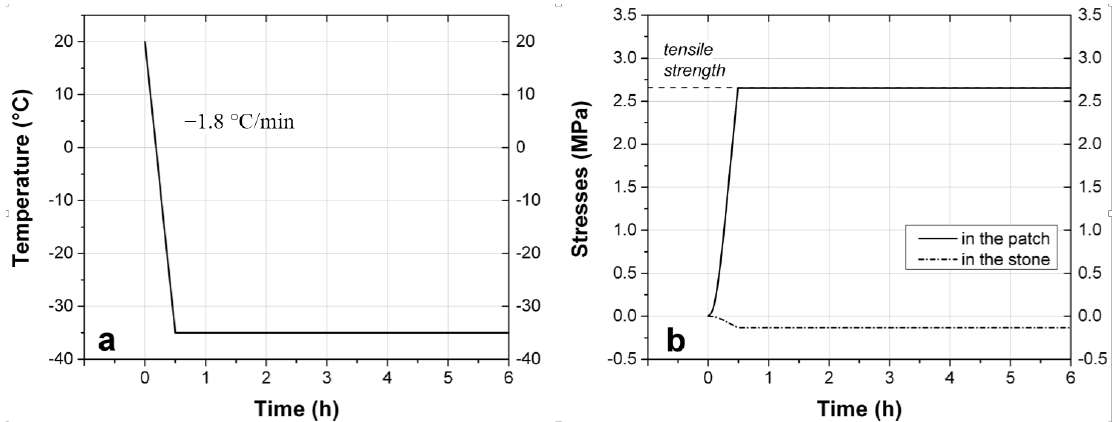
Figure 15. ( a ) The decrease of temperature that could lead to damage in the mortar; ( b ) The stresses induced in the stone and in the mortar by such a decrease in temperature, compared to the tensile strength of the